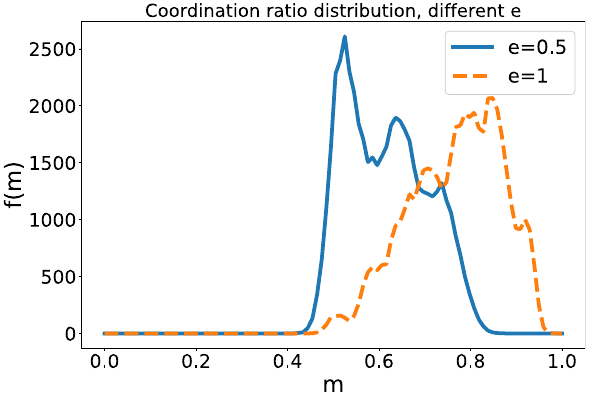
Figure 7. Histograms of the coordination ratio for A i = 1.22 and e = 0, 5 or e = 1 .